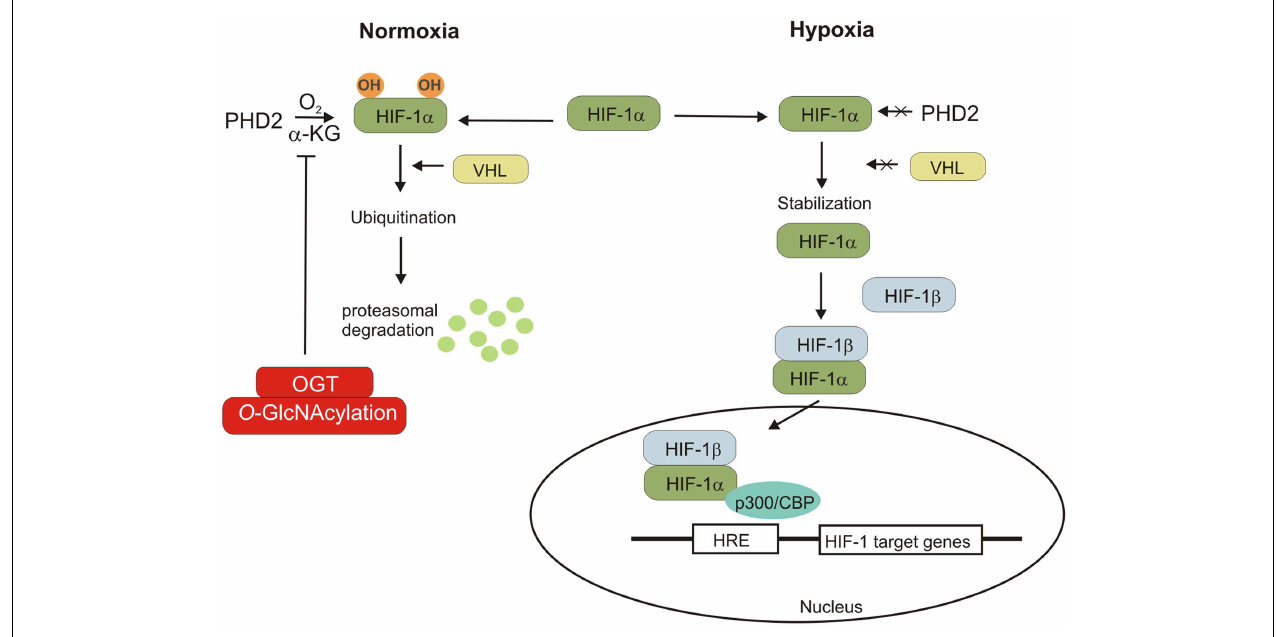
HIF-1 α can associate with HIF-1 β and the cofactor p300/CBP.The HIF-1 complex induces the transcription of genes containing hypoxia-responsive elements (HRE). OGT regulates stability of HIF-1 α via regulation of α -ketoglutarate levels and inhibiting HIF-1 α